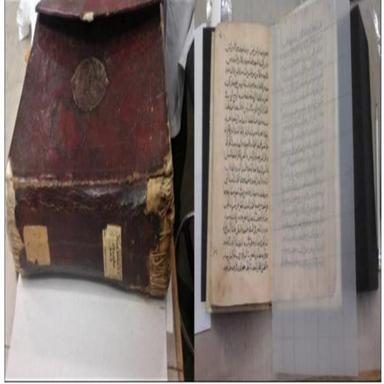
An example of the Arabic Christian manuscript under study (left) and the sampling procedure (right) Vat. Ar. 157 p. 54 with Borg.ar.243 6r and Vat.ar.157 ff. 52v - 53r.